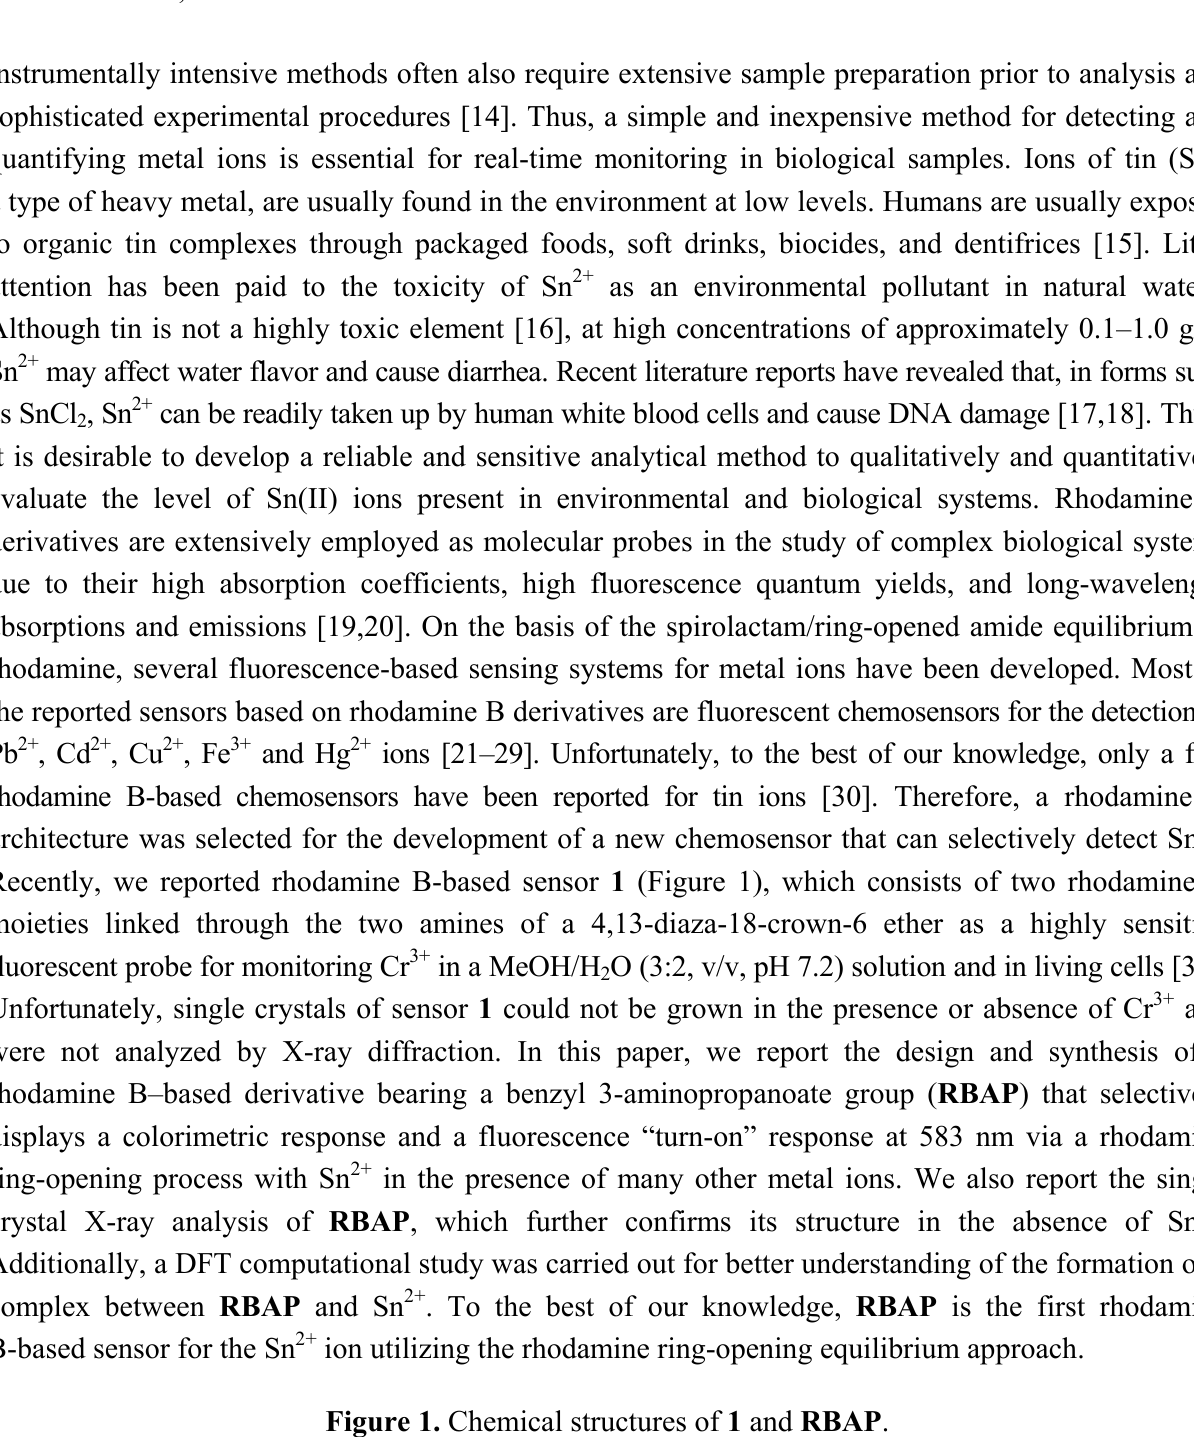
Figure 1. Chemical structures of 1 and RBAP